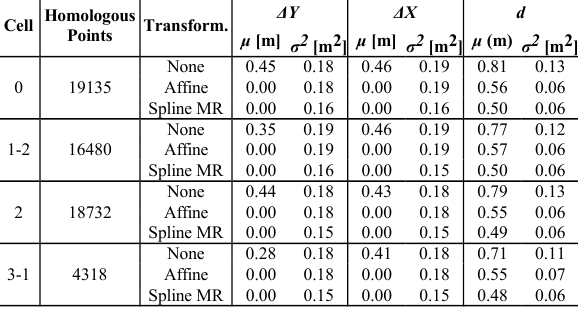
Cell Homologous Points Transform.